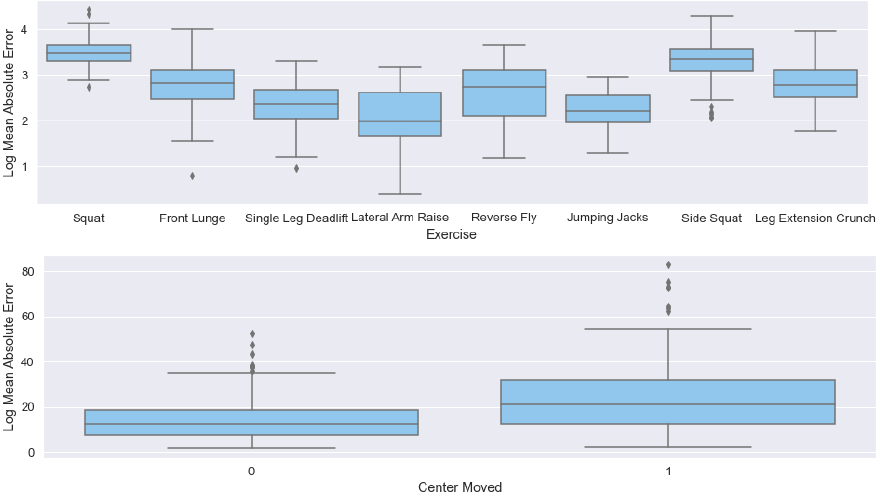
Figure 10. Boxplots representing the MAE in degrees on the logarithmic scale across all performed exercises and the pelvic center moved variable in the experiments. Both boxplots show significant differences in the mean and variance across the variables.